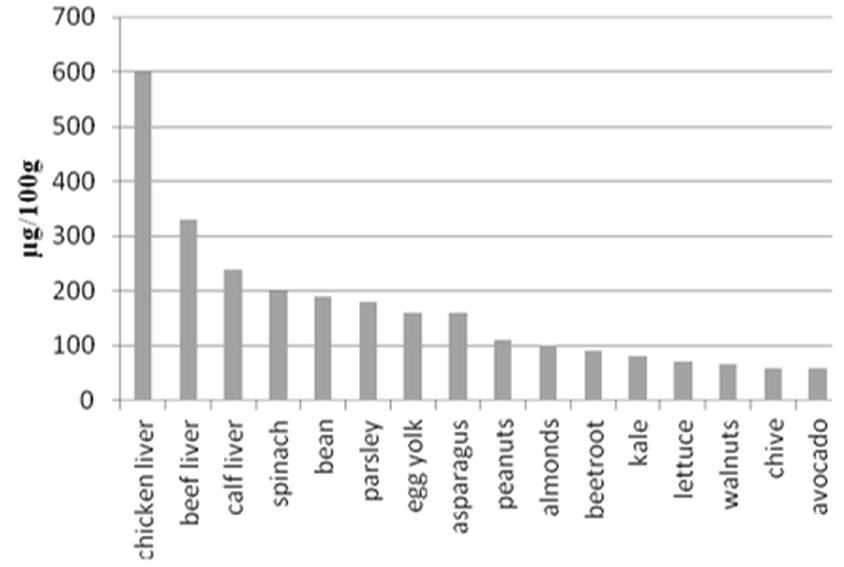
Figure 4: Folates content in selected food [Fig. own